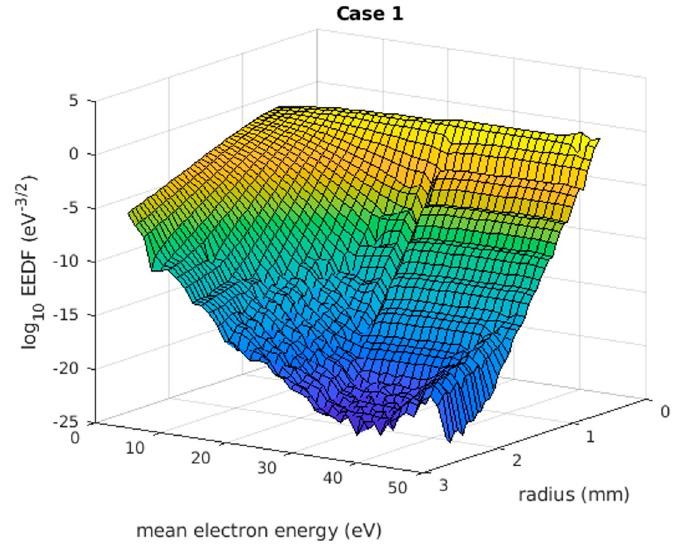
Figure 4. EEDF simulated distribution surface against radial distance from the Corona tip and the mean electron energy for the reference engine conditions.